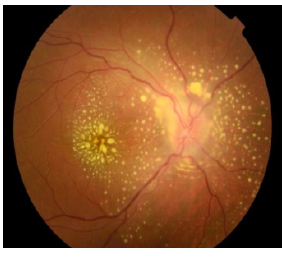
Figure 4. Cystoid Macular Edema after Glaucoma